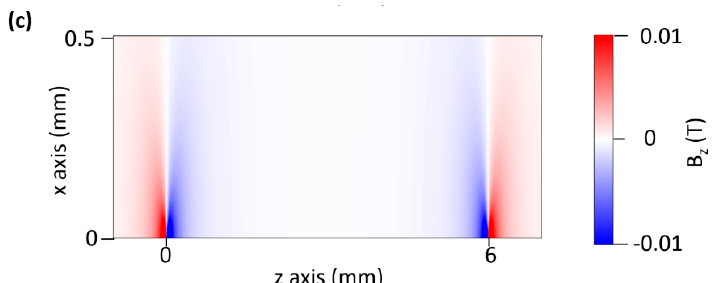
Figure 8. ( a ) Schematic representation of the interaction among the core-shell magnetic nanoparticle and the magnetoelastic ribbon. M is the magnetization of the ME ribbon, m is the magnetic moment of the core-shell nanoparticle and r indicates the position in the chosen reference system. ( b , c ).Intensity of the x and z components x of the magnetic induction field ( B x and B x ) in the symmetry plane x-z of the ribbon (y = 0.5 mm).